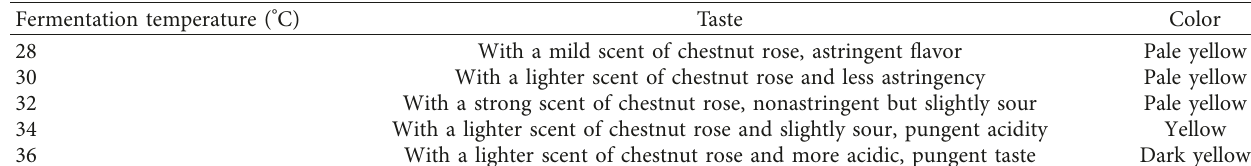
Figure 6: Effect of different heating temperatures on the vitamin C content of chestnut rose jiaosu. Table 8: Jiaosu flavor under different temperature fermentation conditions.